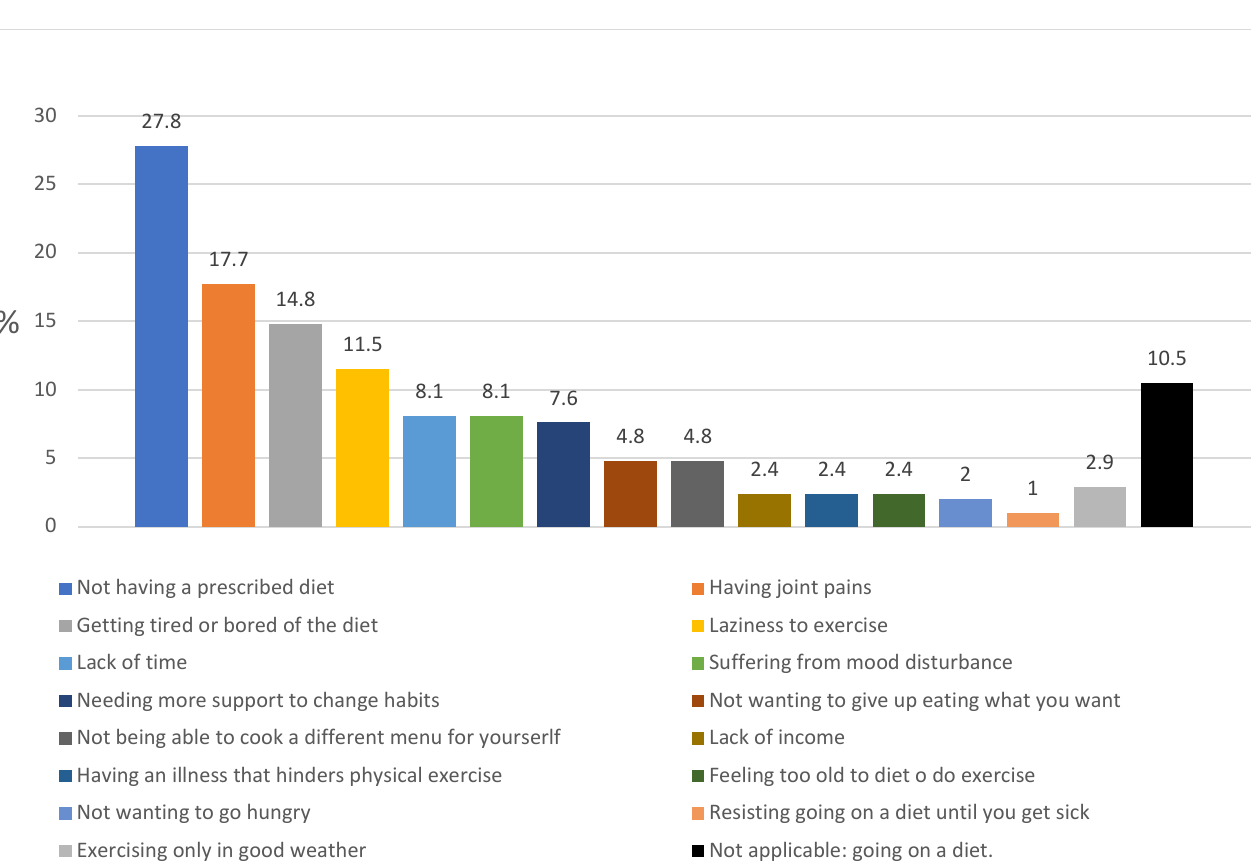
Figure 1. Limiting factors mentioned by patients.